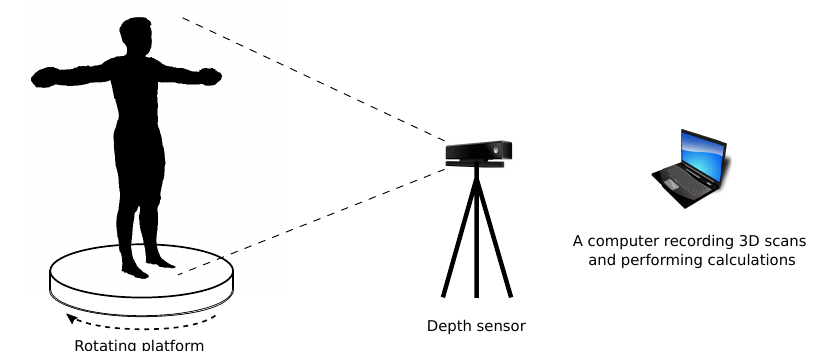
Figure 2. System for scanning human anthropometric